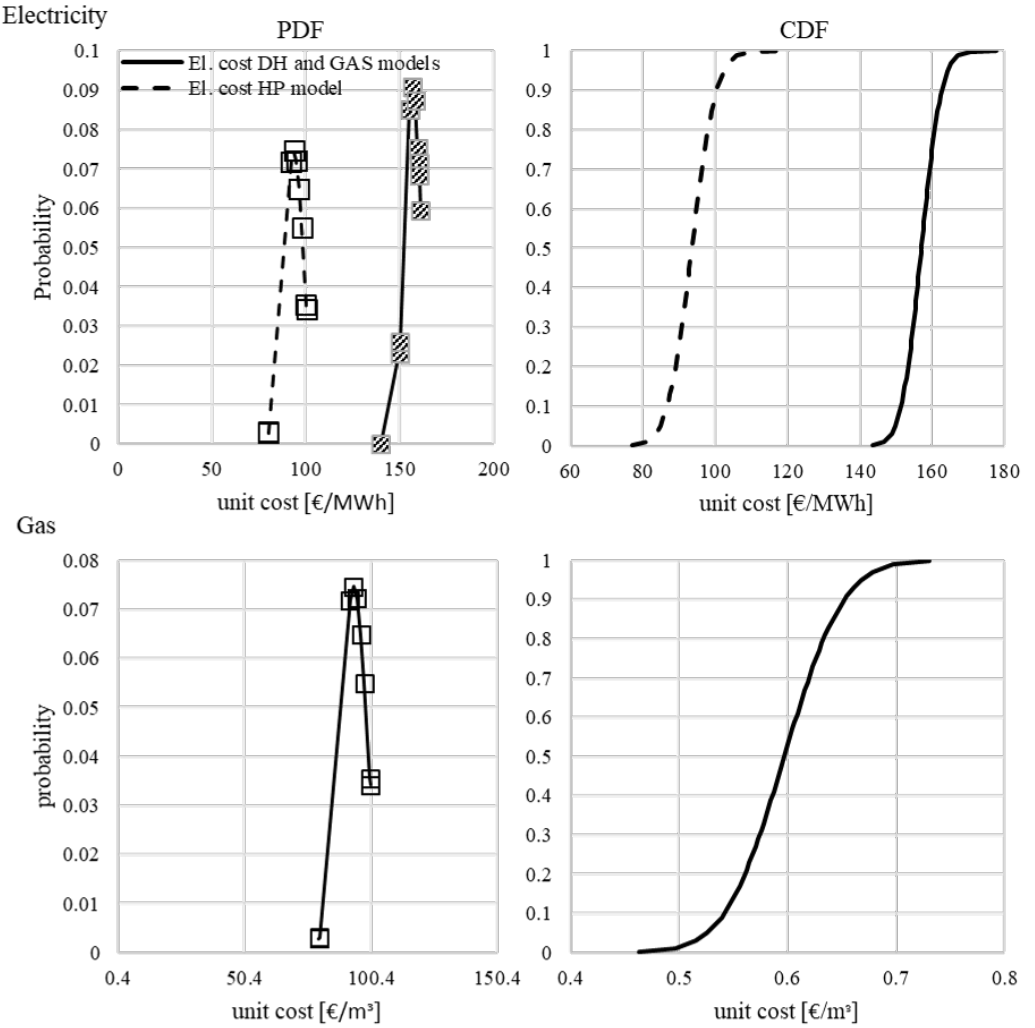
Figure 7. Probability density function (PDF — left) and cumulative distribution function (CDF — right) for electricity and gas, respectively.